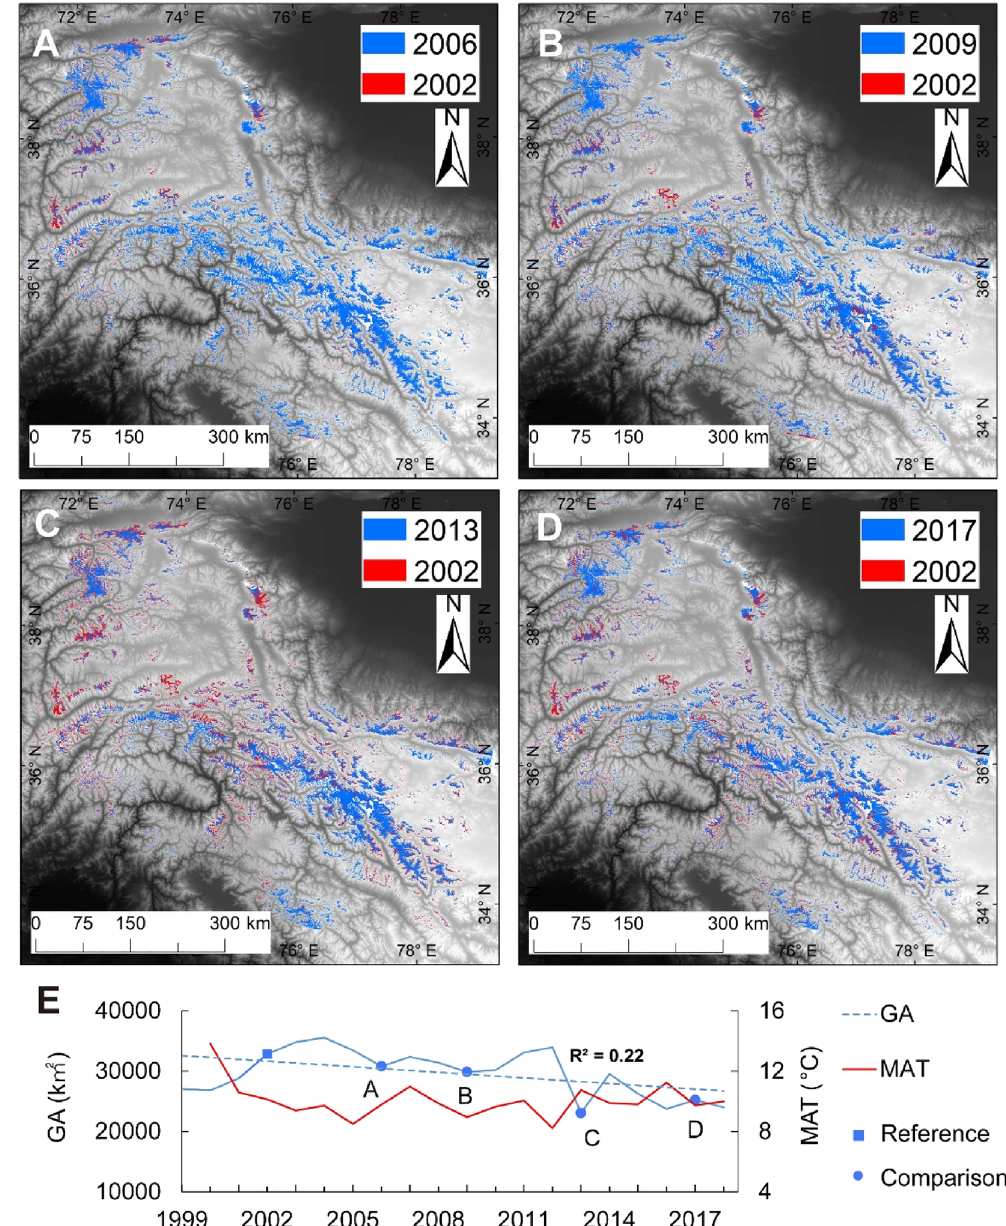
Figure 8. Comparison of glacial area in the study region for selected years. Panels ( A – D ) show glacial extent in 2002 and four other years (2006, 2009, 2013 and 2017, respectively). In each case, red indicates glacial extent lost during the time indicated, blue indicates glaciers present at both times. Panel E summarizes the overall trends in glacial area (GA) and mean annual temperature (MAT) during 20 years studied (Figures created using Arcgis10.2 https ://www.esri.com/en-us/arcgi s/produ cts/arcgi s-deskt